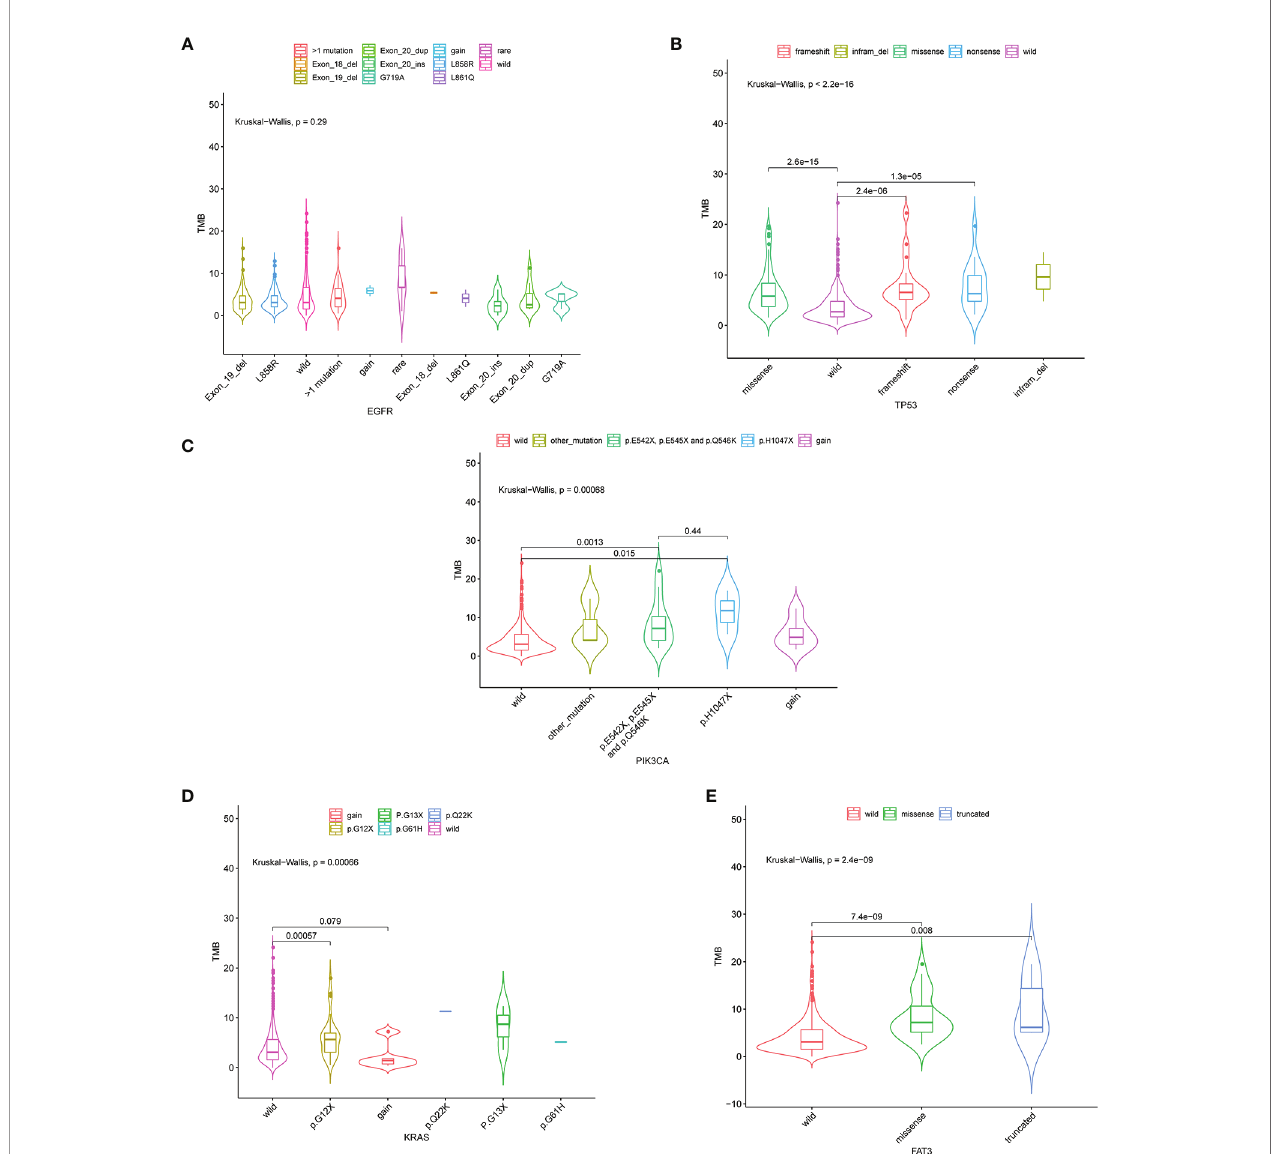
FIGURE 3 | Violin plots of EGFR, TP53, PIK3CA, KRAS gene mutation types and the distribution of tumor mutation burden (TMB). Correlation between TMB and EGFR (A) , TP53 (B) , PIK3CA (C) , KRAS (D) and FAT3 (E)